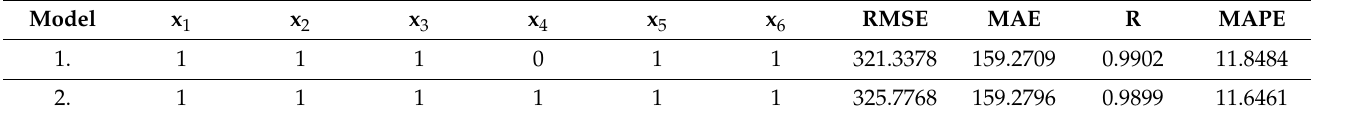
Table 5. Comparative analysis of concrete consumption models with different sets of input varia ‐ bles.